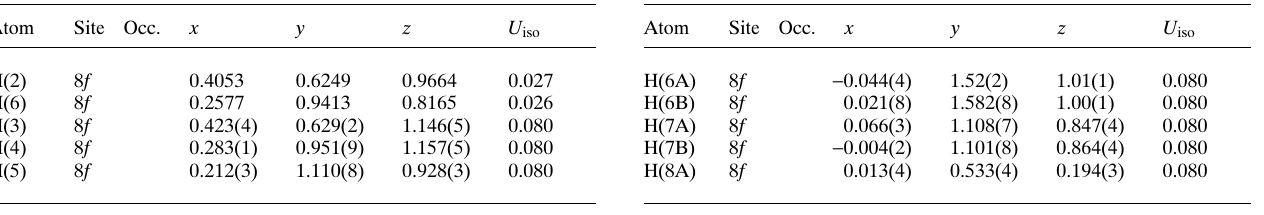
Table 2. Atomic coordinates and displacement parameters (in Å 2 )